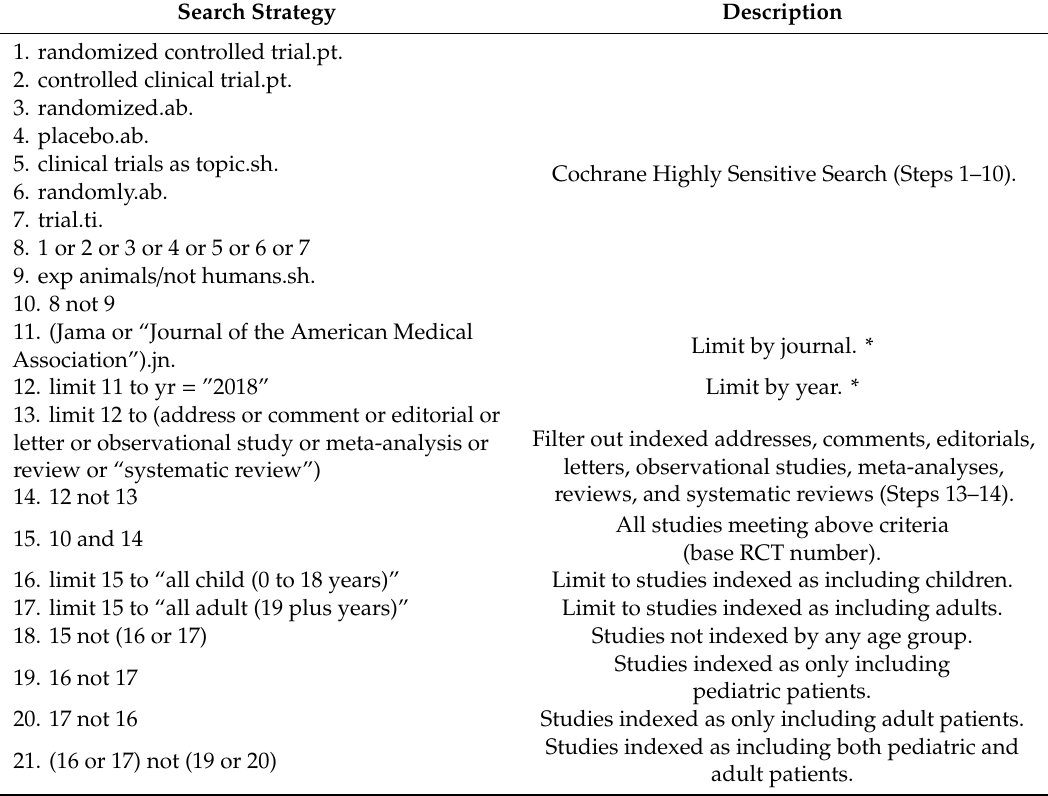
Table 1. Ovid Medline search strategy for locating indexed pediatric, adult, and mixed randomized controlled trials